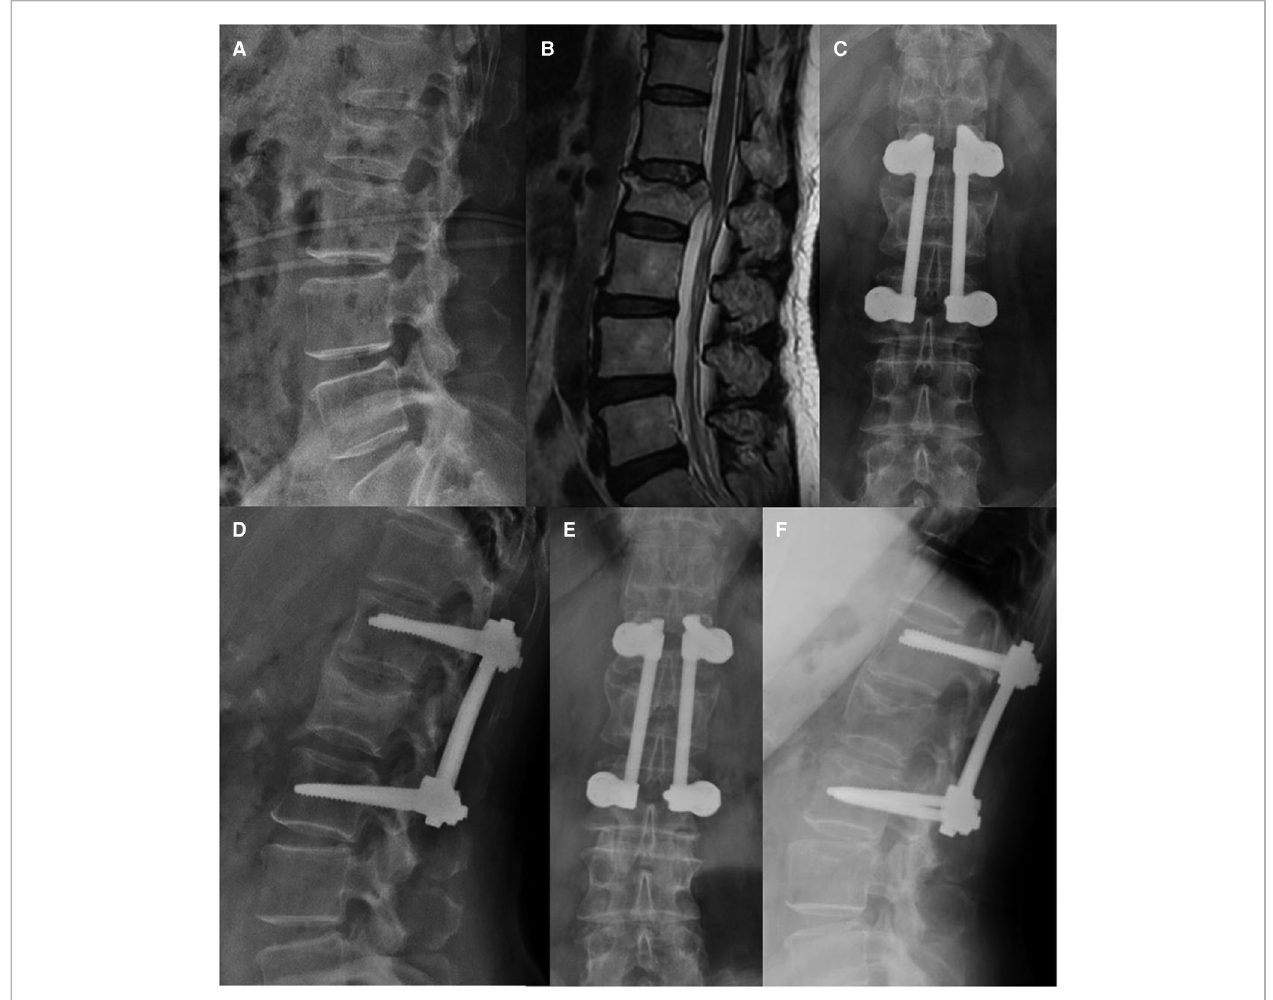
FIGURE 5 | Non-fusion short-segment fi xation using Schanz screws for L2 fracture (type A3). A 66-year-old woman from group B presented in 2014 with severe lower back pain without neurological de fi cit after a traf fi c accident. ( A , B ) Preoperative lateral radiography and T-2 weighted magnetic resonance imaging show a posterior vertebral wall fracture of L2. ( C , D ) Anteroposterior and lateral radiographs at the 1-year follow-up. ( E , F ) At the 51-month follow-up visit, anteroposterior and lateral radiographs show that the implant position remains